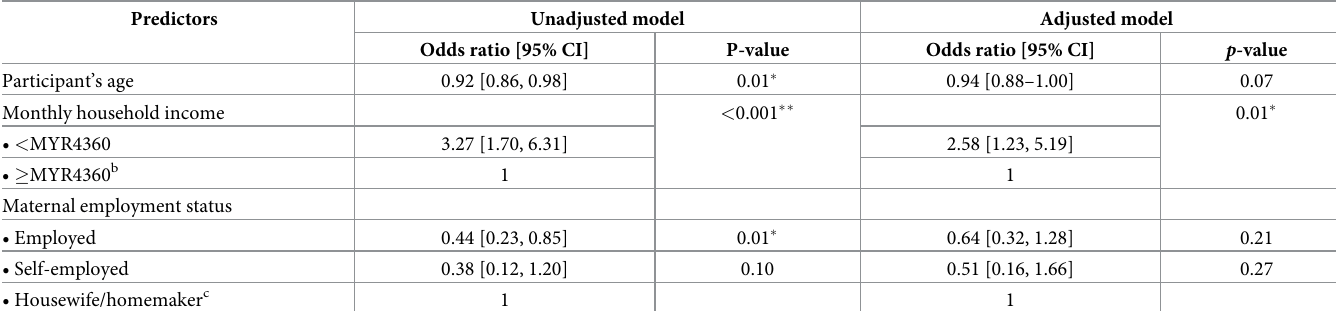
Table 3. Binary logistic regression